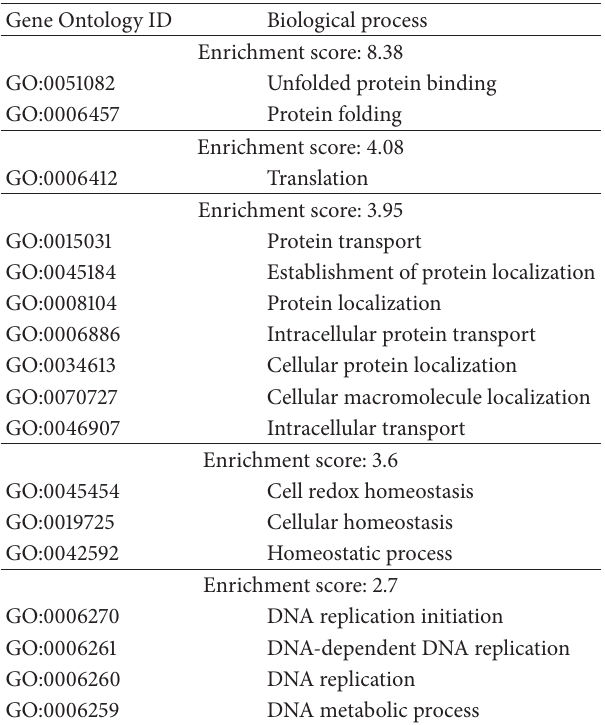
Table 1: Gene Ontology biological process categories enriched by genes differentially expressed in DM relative to